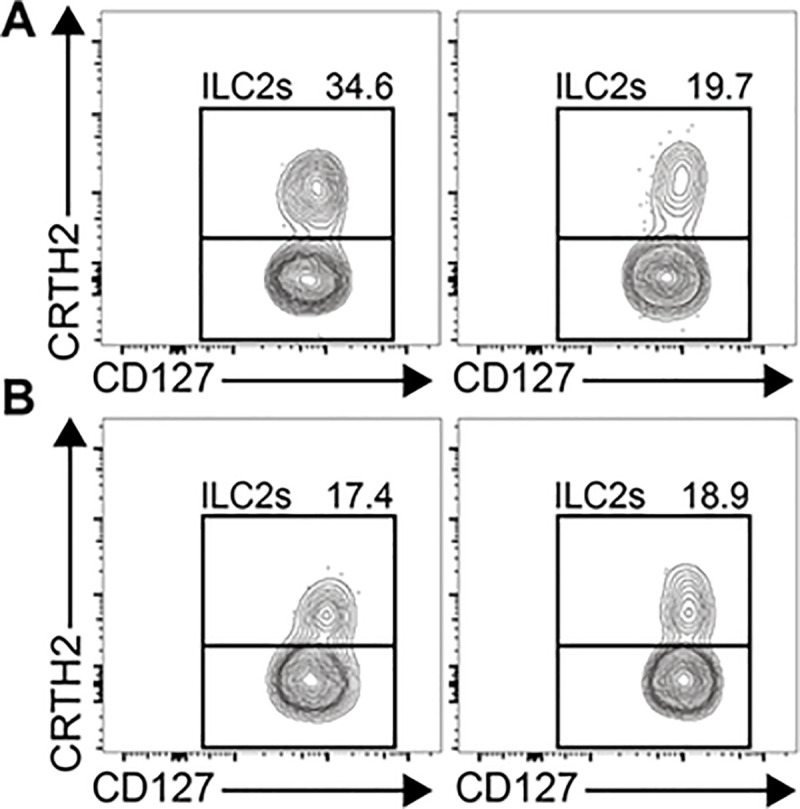
ILC3s decrease in adipose tissue but ILC2s remain the same.ILC-3 numbers/gram of adipose tissue decreased significantly in participants treated with sitagliptin compared to placebo (p = 0.03). Panel A -shows an example of the decrease in ILC-3 in a participant before and after treatment with sitagliptin, respectively. In the same participant, panel B shows no difference in ILC-2 before and after treatment, respectively.